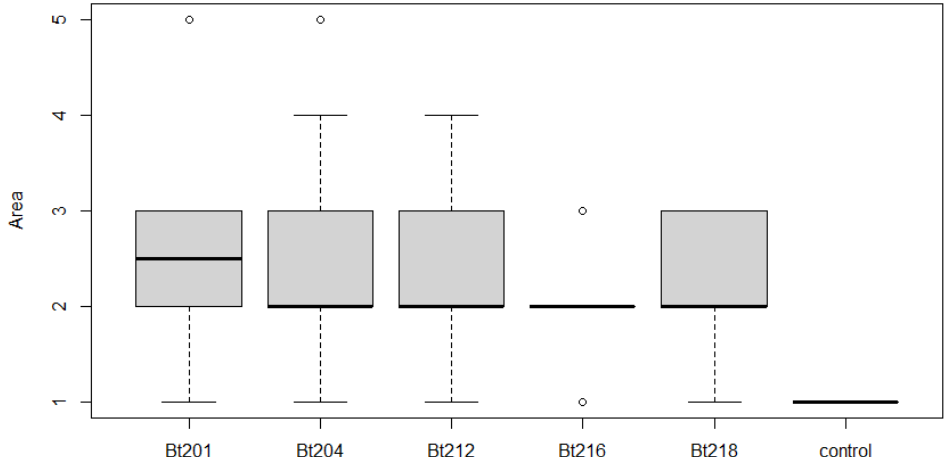
Figure 5. Boxplot of the percentage of infected area on clusters artificially inoculated with Botryosphaeriaceae isolates under study. Scale of evaluation of area infected—1 = no symptoms; 2 = 1–5%; 3 = 5–25%; 4 = 25–50%; 5 = > 50%. The median is represented by the solid line. Top and bottom lines of the box correspond to the 25th and 75th percentiles of the data, respectively. Circles represent outliers.